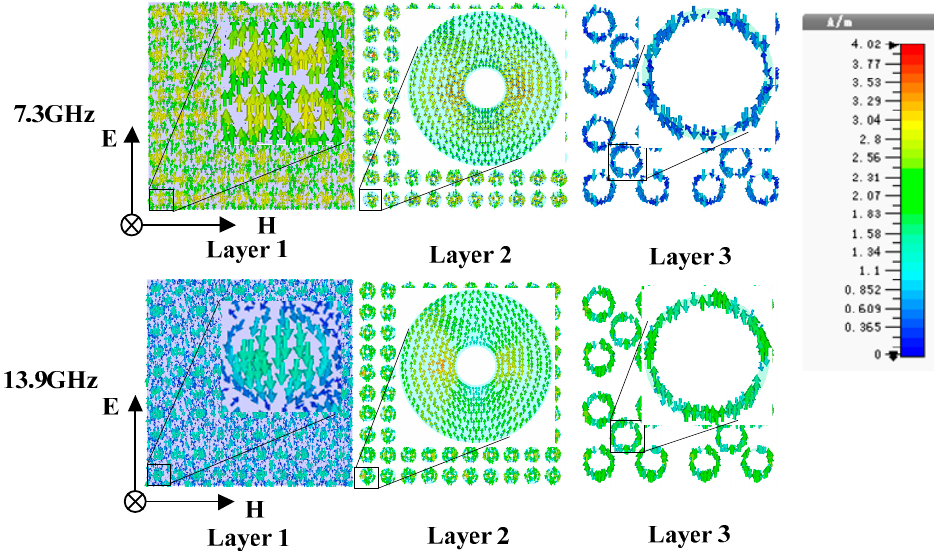
Figure 3. The distributions of surface currents under normally incident TE waves at 7.3 GHz and 13.9 GHz.